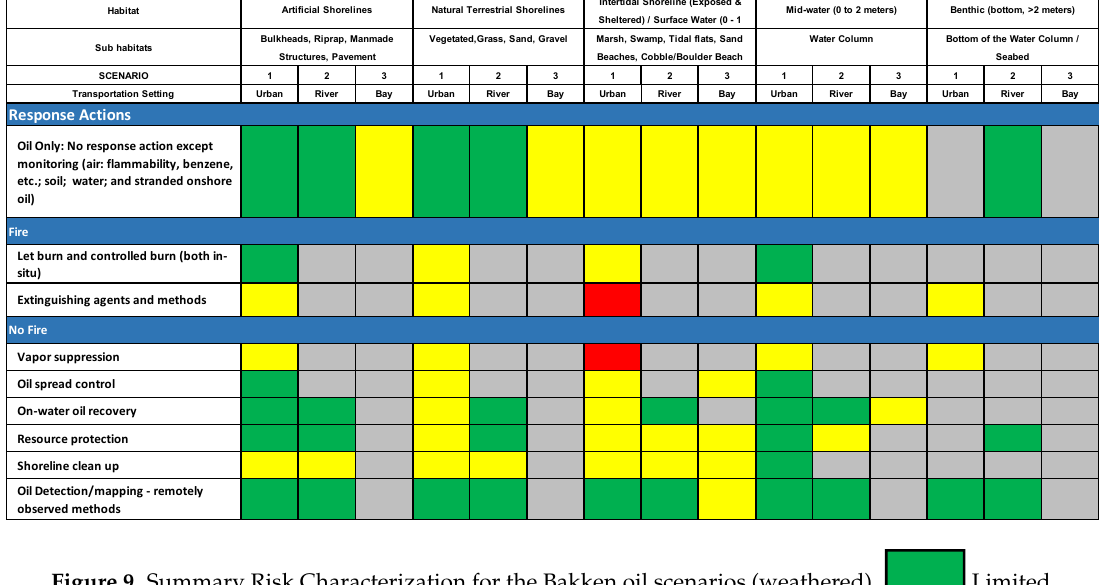
Figure 7. Summary Risk Characterization for the Bakken oil scenarios (initial release). Limited Level of Concern; Moderate Level of Concern; High Level of Concern; High Level of Concern; Not Applicable.